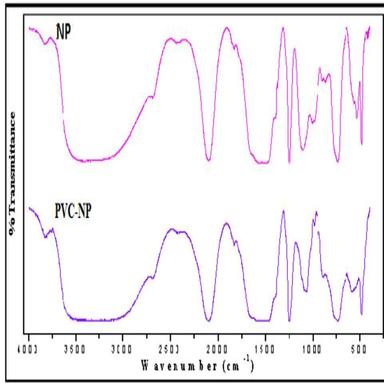
FTIR Spectra of only NP and PVC–NP composite material.